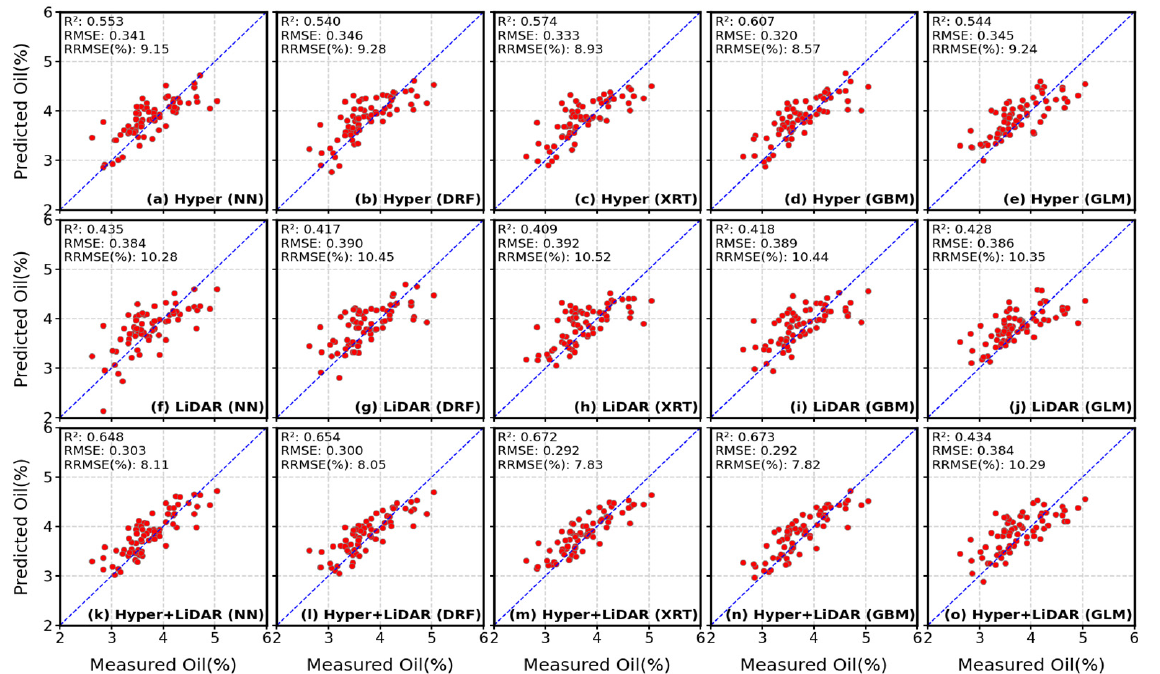
Figure 10. Scatter plots of measured vs. predicted corn oil concentration using different models with hyper-based, LiDAR-based and Hyper + LiDAR-based features, respectively.